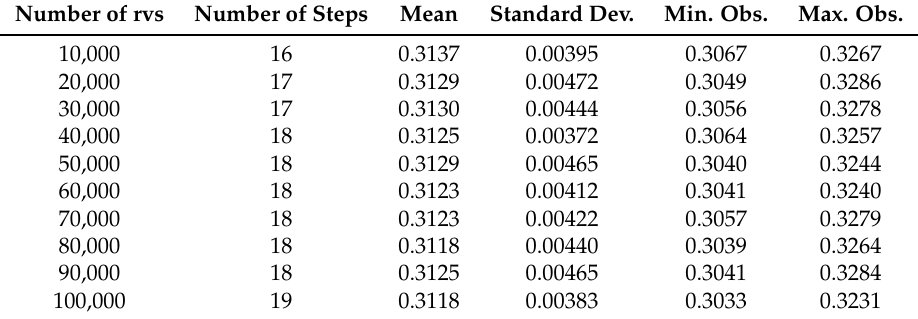
5 + log ( n ) + 1.57 . (cid:100) (cid:101)